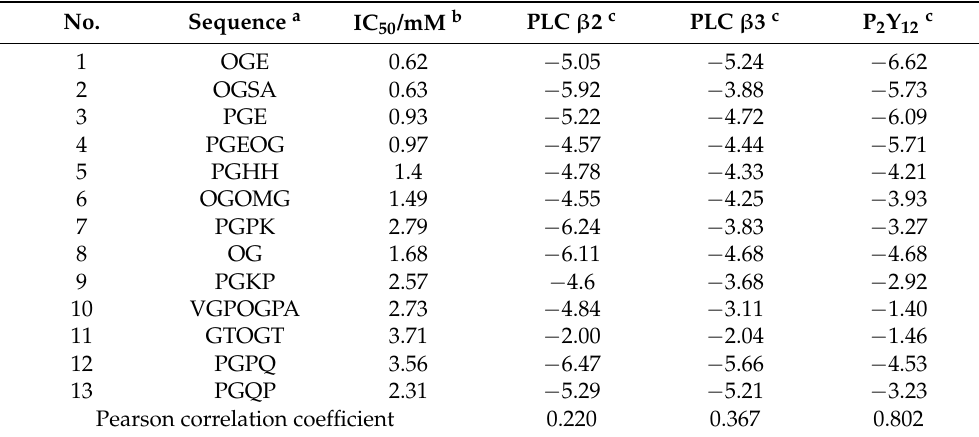
Table 2. The ∆ G bind binding energy (kcal/mol) of 13 antiplatelet peptides with P 2 Y 12 , PLC β 2, and PLC β 3,